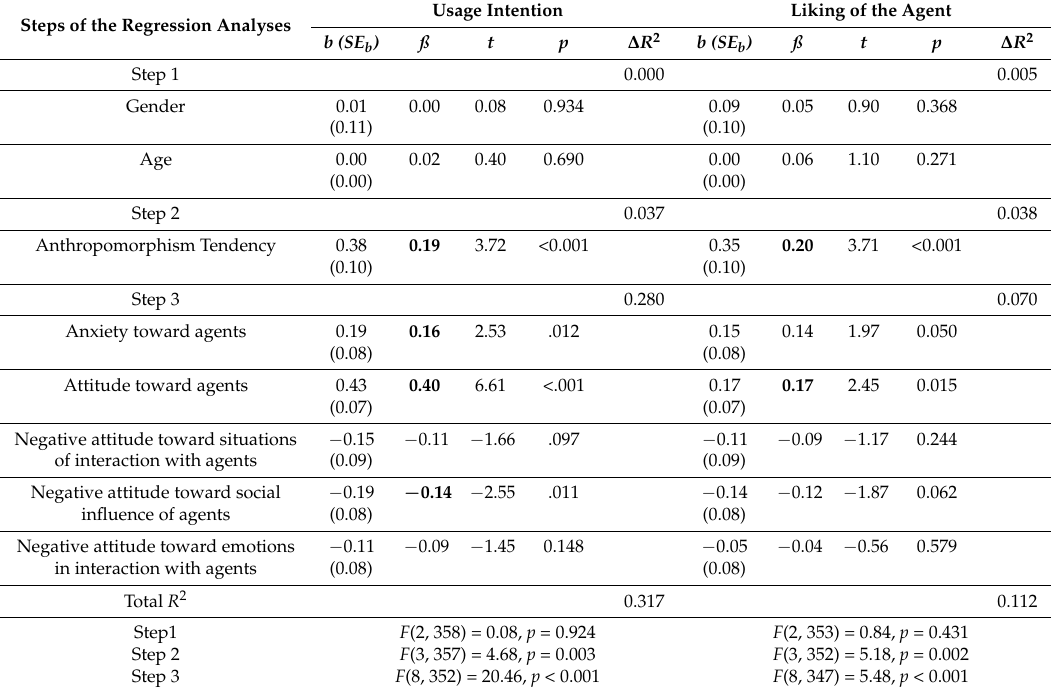
Table 11. Hierarchical multiple regression